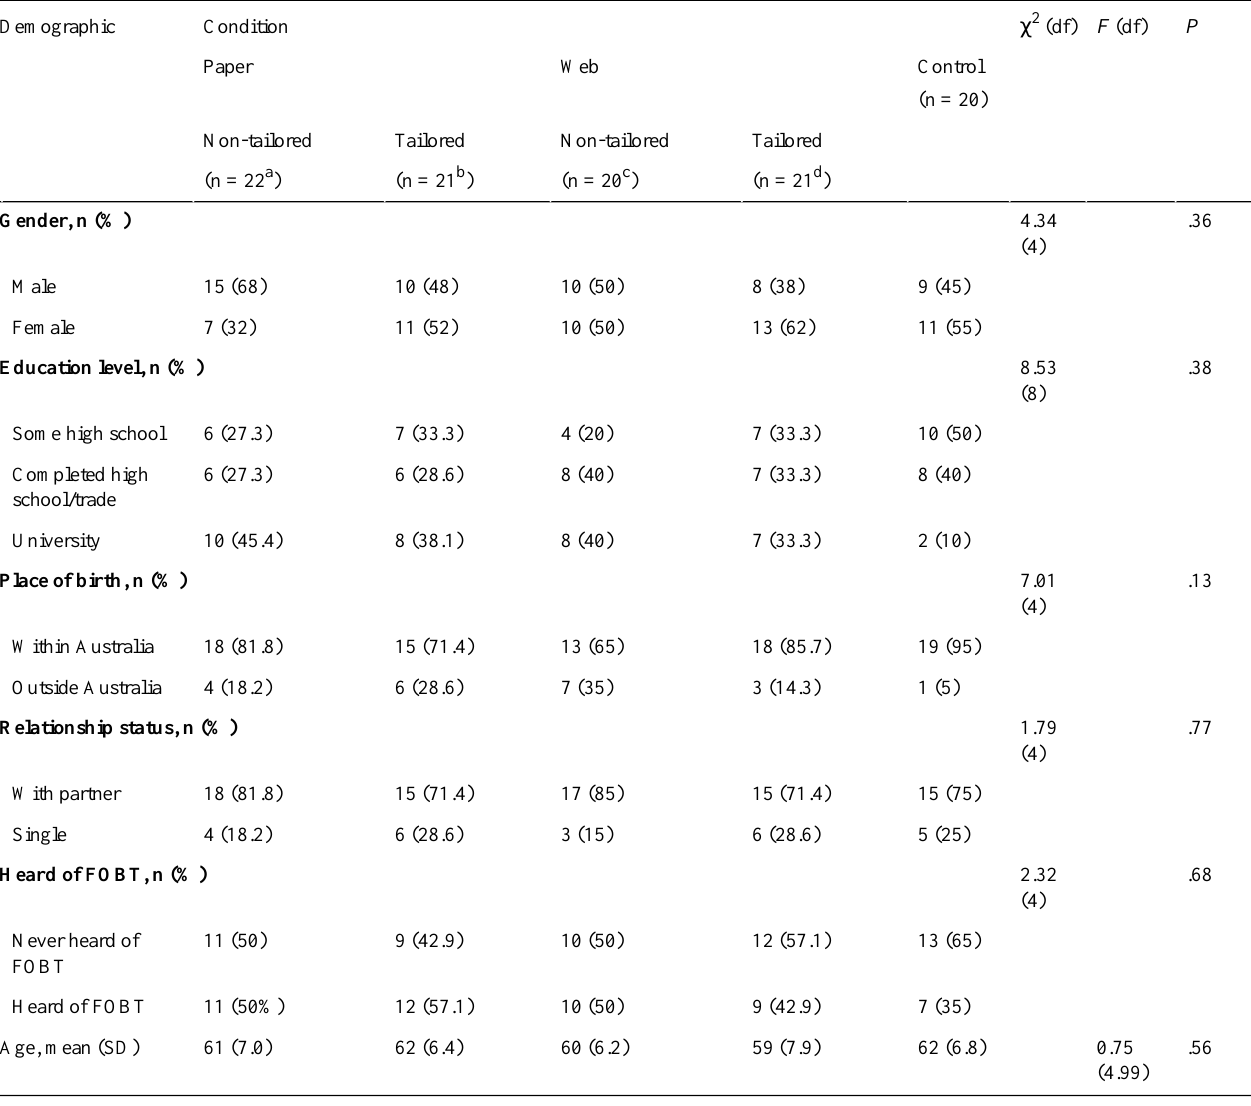
Table 5. Comparison of groups across